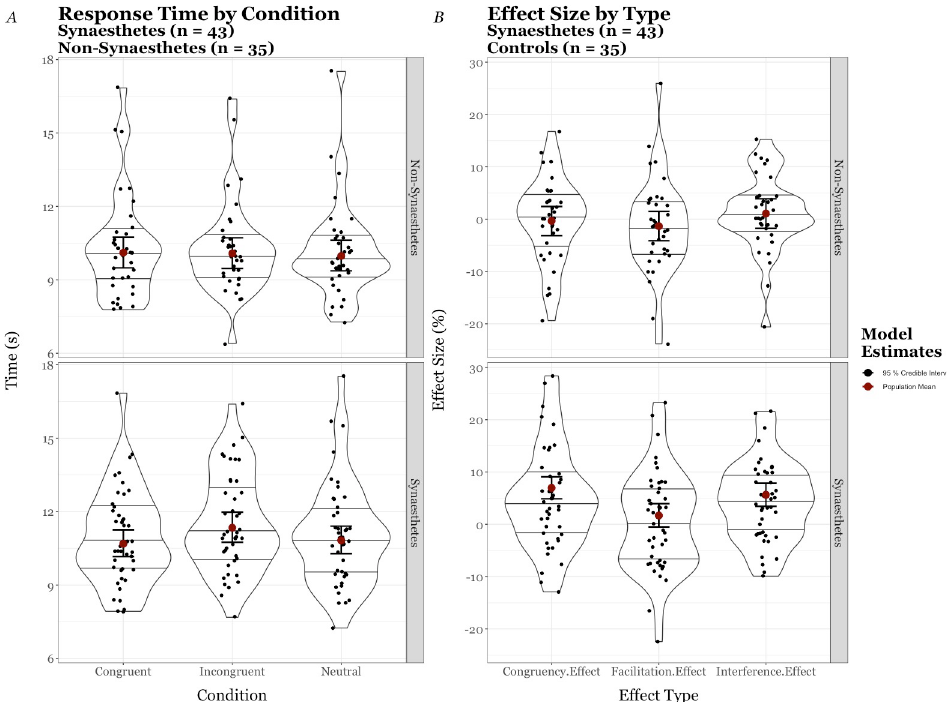
Fig 4. Panel A–Violin plots with superimposed jitter plots of Synaesthetes’ (n = 43) vs Non-Synaesthetes’ (n = 35) median item times(s) by condition with accompanying model estimates of the population mean, and Panel B–Violin plots with superimposed jitter plots of Synaesthetes’ (n = 53) vs Non-Synaesthetes’ (n = 35) Effect size by type with accompanying model estimates of the population effect size.